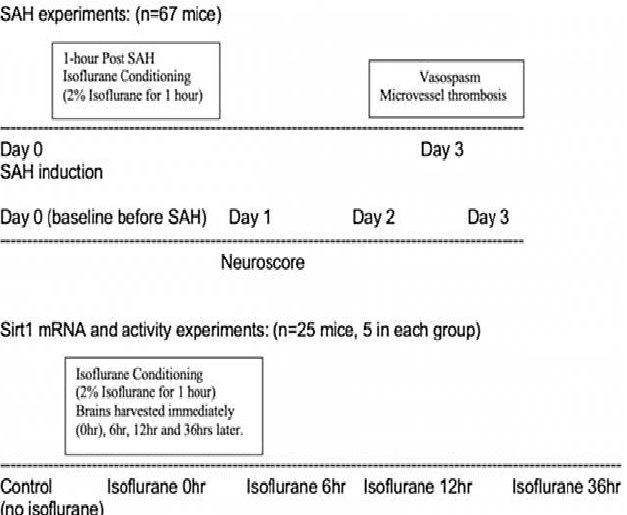
Figure 4. Flow chart representing the overall experimental design. SAH—subarachnoid hemorrhage. Sirt1—silent mating type information regulation 2 homolog.